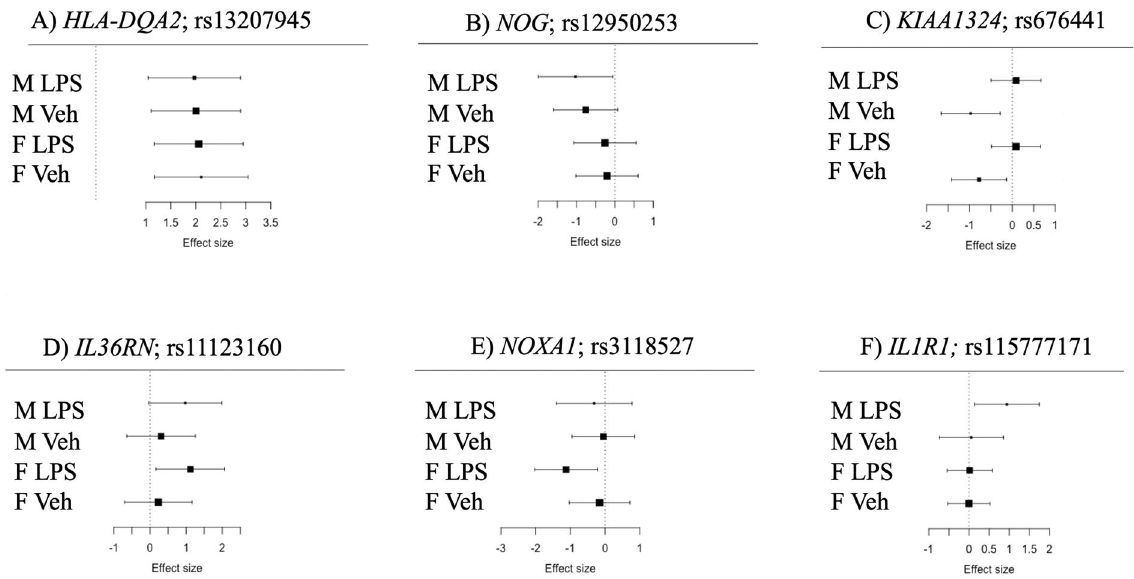
Figure 6. Meta-analysis forest plots showing the effect size (x-axis) of exemplar gene-SNP pairs for each treatment condition (y-axis; M LPS: expression data in males in the LPS-treated samples; M Veh: expression data in males in the untreated controls; F LPS: expression data in females in the LPS-treated samples; F Veh: expression data in females in the untreated controls). Black boxes show the mean effect size; and the size of the box is proportional to the inverse of the standard error (larger boxes indicate a smaller standard error). The gray lines show the 95% confidence intervals. All eQTLs shown are significant in at least one condition at an lfsr < 0.05. ( A ) Example of an eQTL shared across all conditions. HLA-DQA2 , Human leukocyte antigen DQ alpha 2. ( B ) Example of a sex-specific eQTL (males), NOG , Noggin. ( C ) Example of a treatment-specific eQTL (vehicle only), KIAA1324 , estrogen-induced gene 121 protein. ( D ) Example of a treatment-specific eQTL (LPS only). IL36RN , interleukin 36 receptor antagonist. ( E ) Example of a treatment specific and sex specific eQTL (Female LPS only), NOXA1 , NADPH oxidase activator 1. ( F ) Example of a treatment specific and sex specific eQTL (Male LPS only), IL1R1 , interleukin 1 receptor type 1.